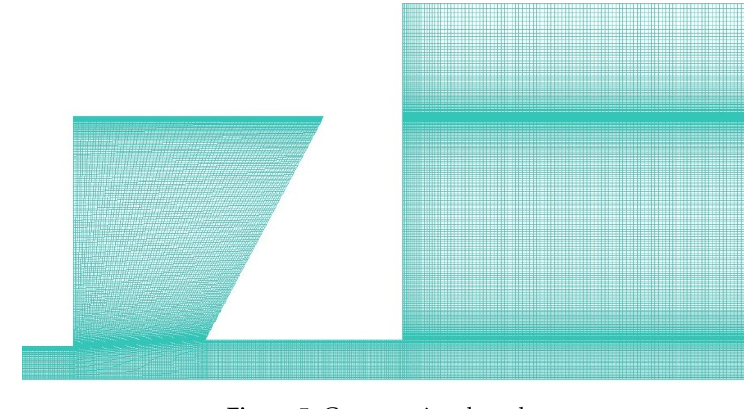
Figure 5. Computational mesh.